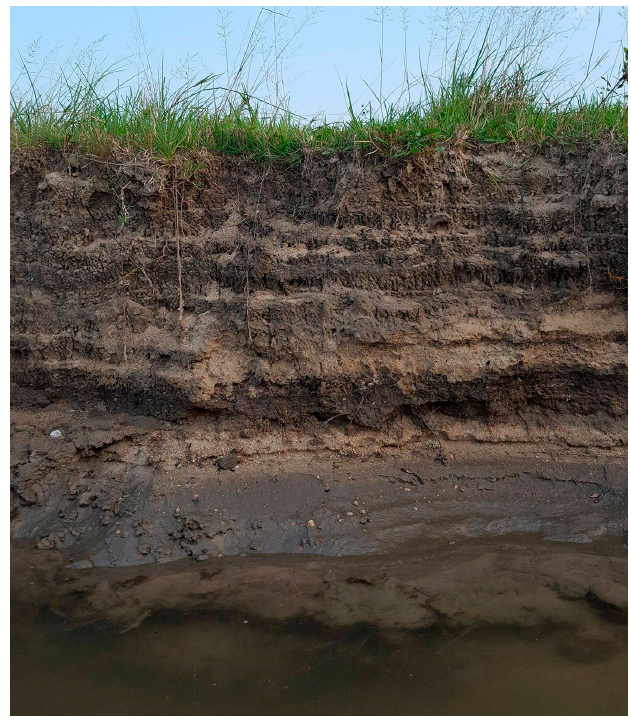
Figure 2. Typical streambank on Cedar River. Note the transition from sandy soil at the top to silty loam in the bottom.